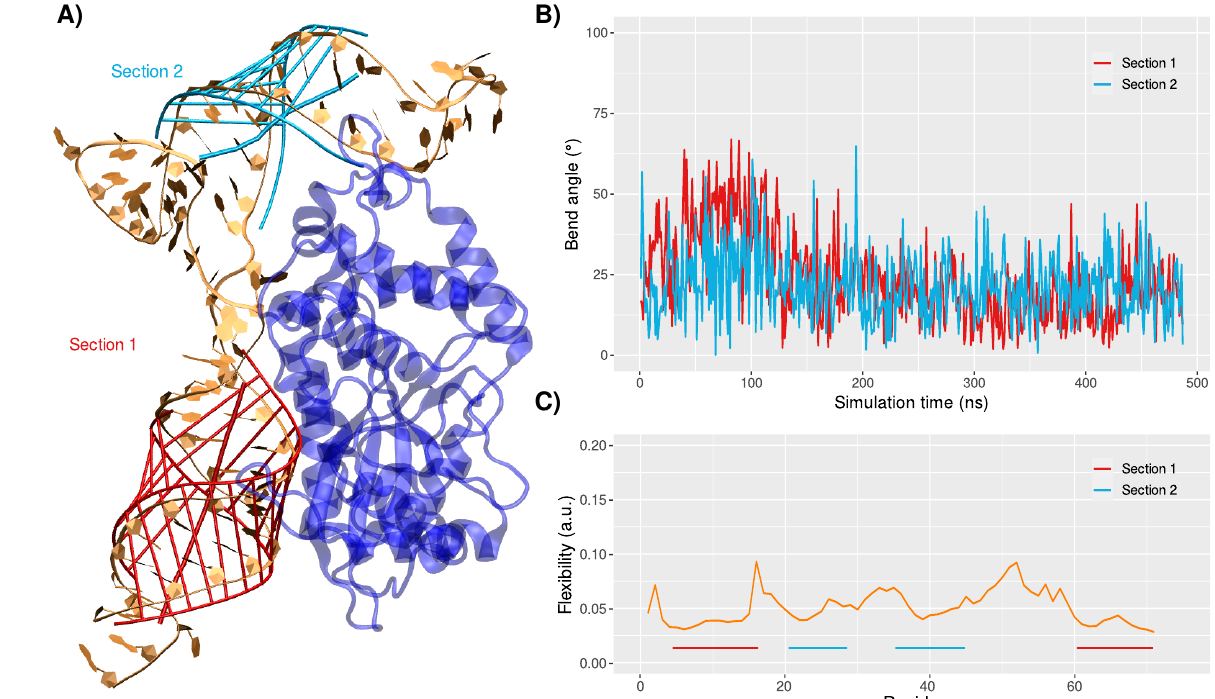
Figure 4. ( A ) Projection of the bend and network interaction in the stem sections 1 (red) and 2 (cyan) onto the major conformation characterized for the OAS1-RNA complex. ( B ) Evolution of the local bend angles of the two stem sections. ( C ) Flexibility profile per residue of the 5 (cid:48) -UTR RNA. The stem regions are indicated by red (first section) and cyan (second section)